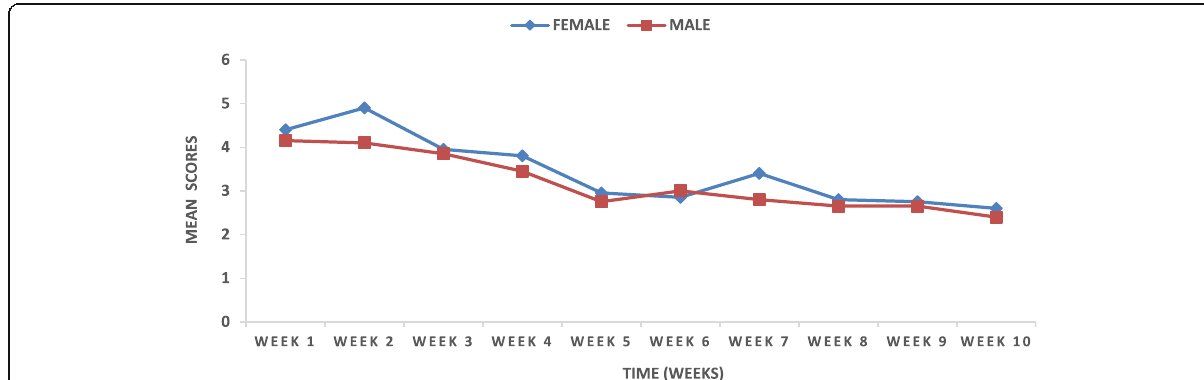
Fig. 4 Line graph showing the mean comparison of pain levels (post visual analogue scale scores) between males and females across 10 weeks (after the intervention). There were spikes in pain perception at the 2nd and 7th weeks in the female group, and 6th and 7th in the male group after acupuncture TENS